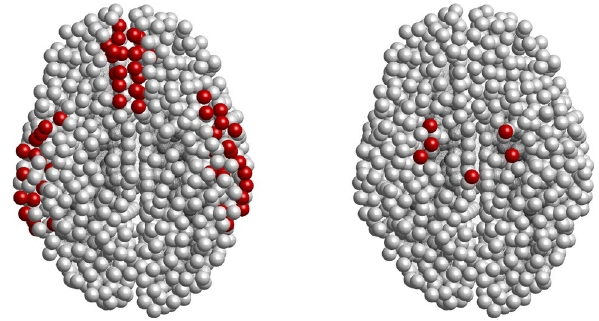
Figure 1. (Color online) Initial seeding sites for Alzheimer’s disease: (left) toxic A β and (right) toxic τ P.